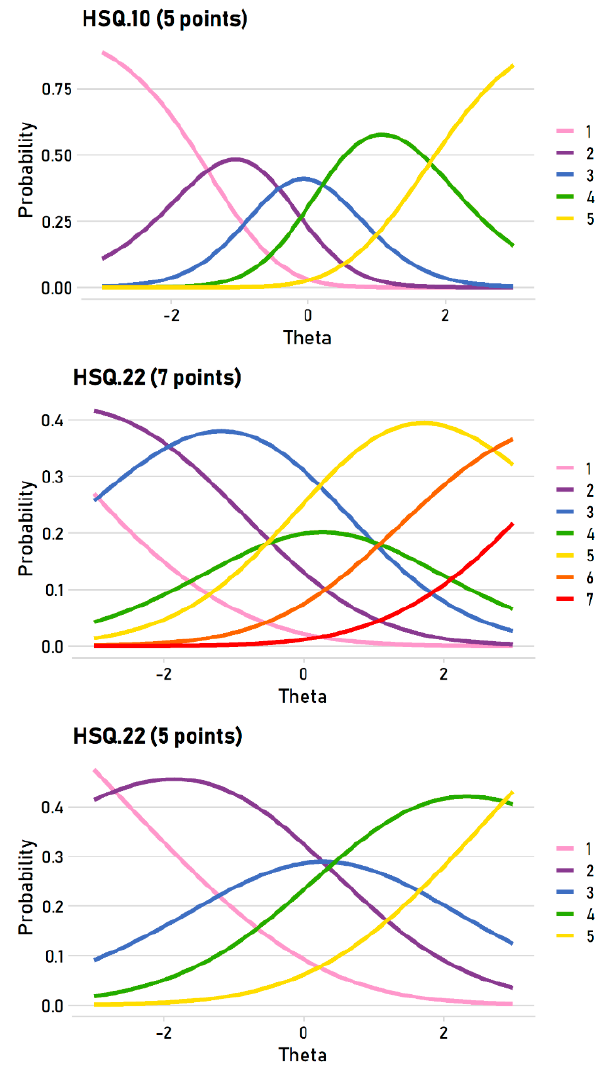
Figure 1. An example of an ideal, ordered pattern of item thresholds (TOP), a disordered item (7-point scale; MIDDLE), and the ordered version of that item (5-point scale; BOTTOM).